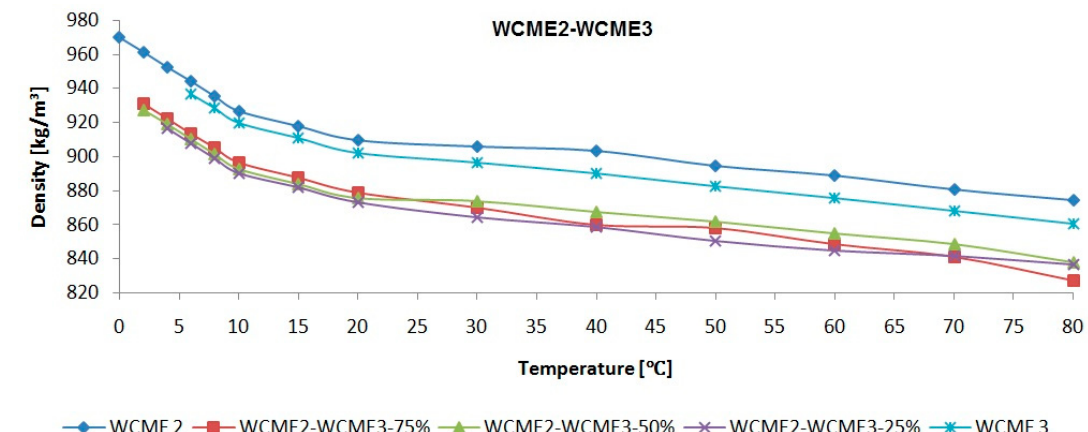
Figure 5. The density of WCME1-WCME2 versus temperature for the di ff erent volume fraction of WCME2.